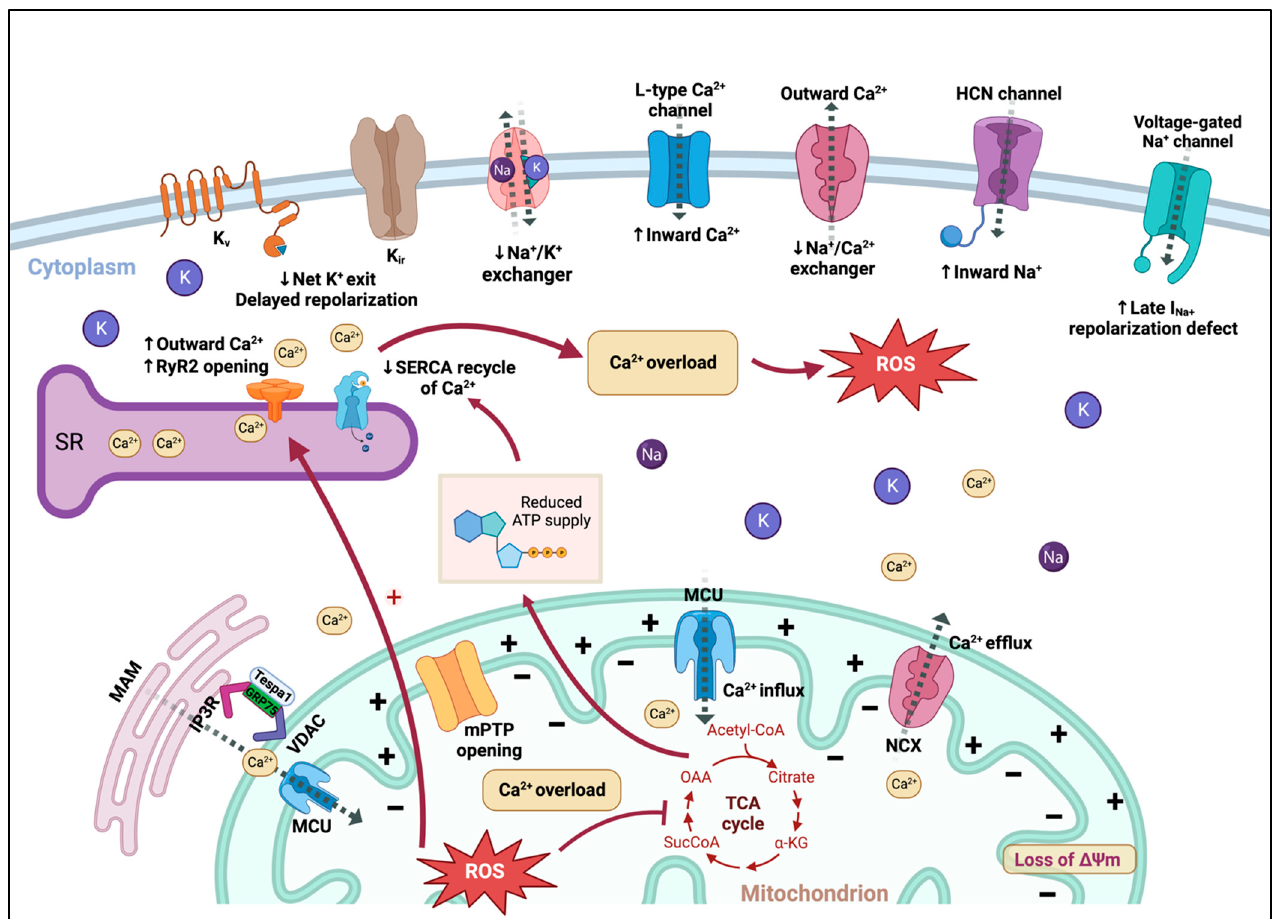
Figure 2. Holistic overview of sarcolemmal and intracellular ion balances in cardiomyocytes and their alterations under mitochondrial dysfunction. Sarcoplasmic reticulum (SR) oversees Ca 2+ storage and releasing into the cytosol. The main Ca 2+ release channel in cardiomyocytes is RyR2 while SERCA recycles Ca 2+ during diastole. ROS increase RyR opening and reduce SERCA recycling via decreased ATP production, thereby causing Ca 2+ overload. Increased inward Na + from HCN channel can reverse the Na + /Ca 2+ exchanger activity and subsequently lead to intracellular Ca 2+ overload and arrhythmias. Moreover, under excessive ROS generation, a net decrease in K + exit along with increased inward late Na + current can cause delayed repolarization and prolonged action potential duration (APD). Sarcoplasmic reticulum mitochondrial contacts (SRMCs) are another important location of calcium transport regulation. The IP3R/GRP75/VDAC complex interacts with MCU to relocate Ca 2+ into the mitochondria matrix. Brown dashed arrows represent directions of ion currents; black solid arrows represent increased or suppressed channel activities.